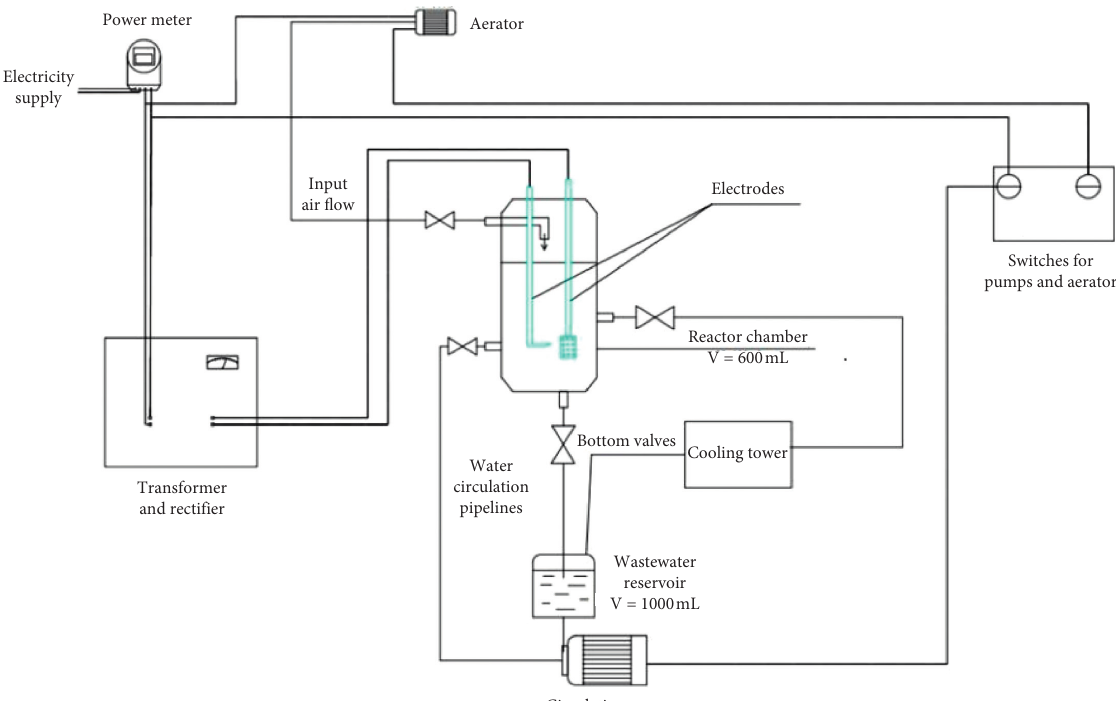
Figure 1: The cold plasma reactor